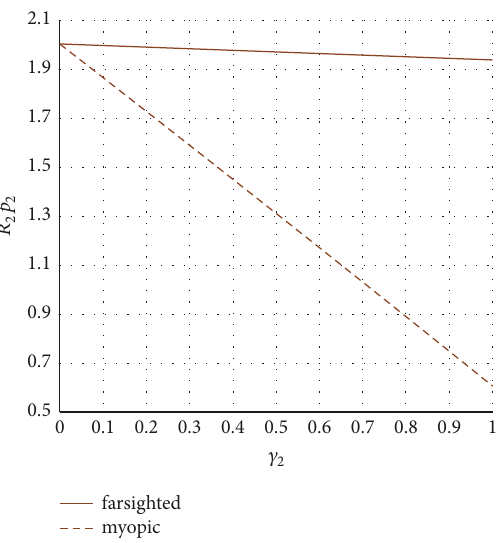
Figure 7: The emission-price product as 𝛾 2